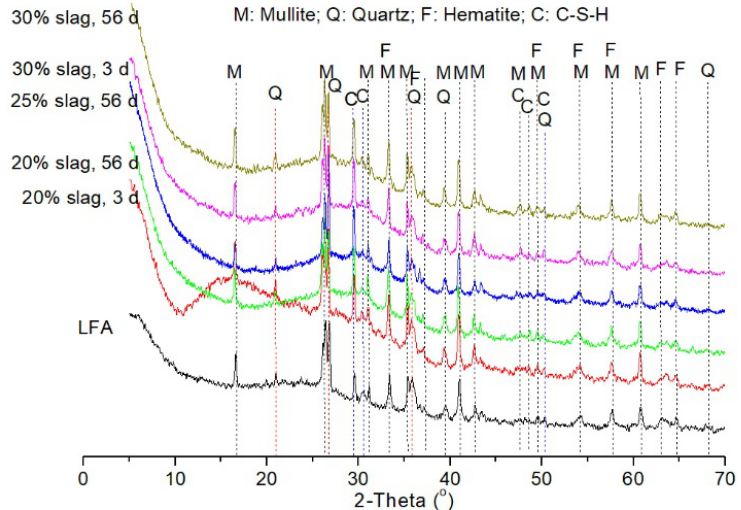
Figure 9. X-ray di ff raction (XRD) patterns of alkali activated LFA-GGBS hybrid binder with di ff erent Figure 9. X-ray diffraction (XRD) patterns of alkali activated LFA-GGBS hybrid binder with different GGBS content at di ff erent curing GGBS content at different curing ages.